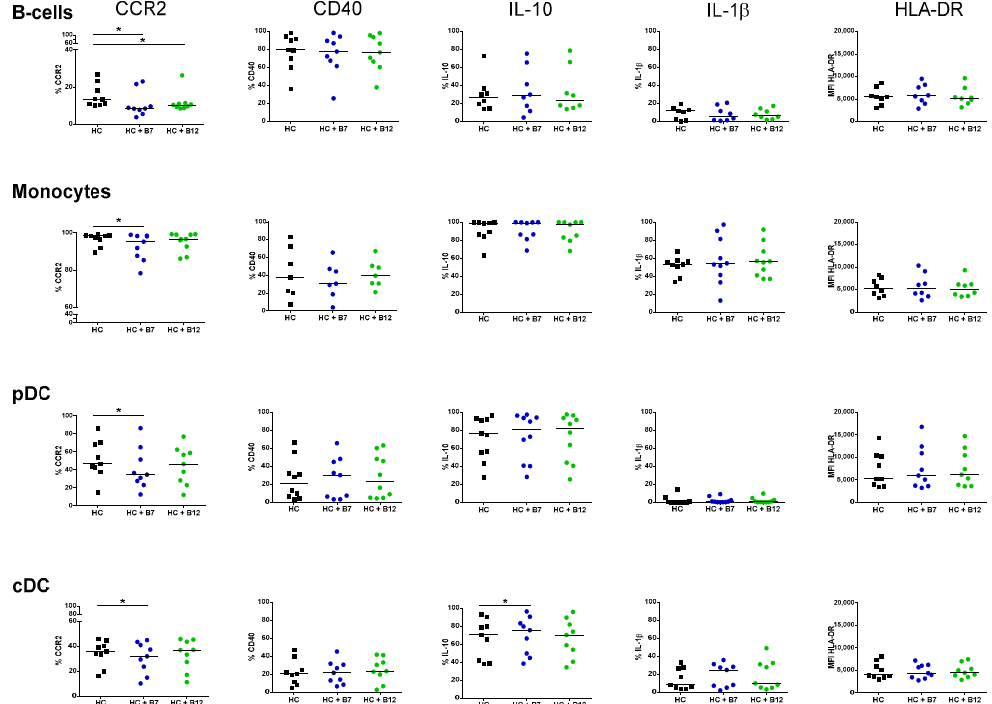
Figure 3. Immunomodulatory e ff ect of bacterial peptides over circulating antigen presenting cells from healthy controls. The e ff ect of bacterial peptides B7 and B12 over the phenotype and cytokine production of B-cells, monocytes, plasmacytoid dendritic cells (pDCs), and conventional dendritic cells (cDCs) from healthy controls (HCs) was determined. Cell subsets were identified as in Figure 2, and characterized following overnight culture in the absence (HC) and presence of bacterial peptides B7 (HC + B7) and B12 (HC + B12). Results are expressed as percentage of positive cells (%) for CCR2, CD40, IL-10, and IL-1 β or by the median fluorescence intensity (MFI) for HLA-DR in each given subset. The Wilcoxon paired test was applied to determine statistical di ff erences in the levels of each marker within each subset for both peptides versus resting conditions. p -values < 0.05 were considered significant